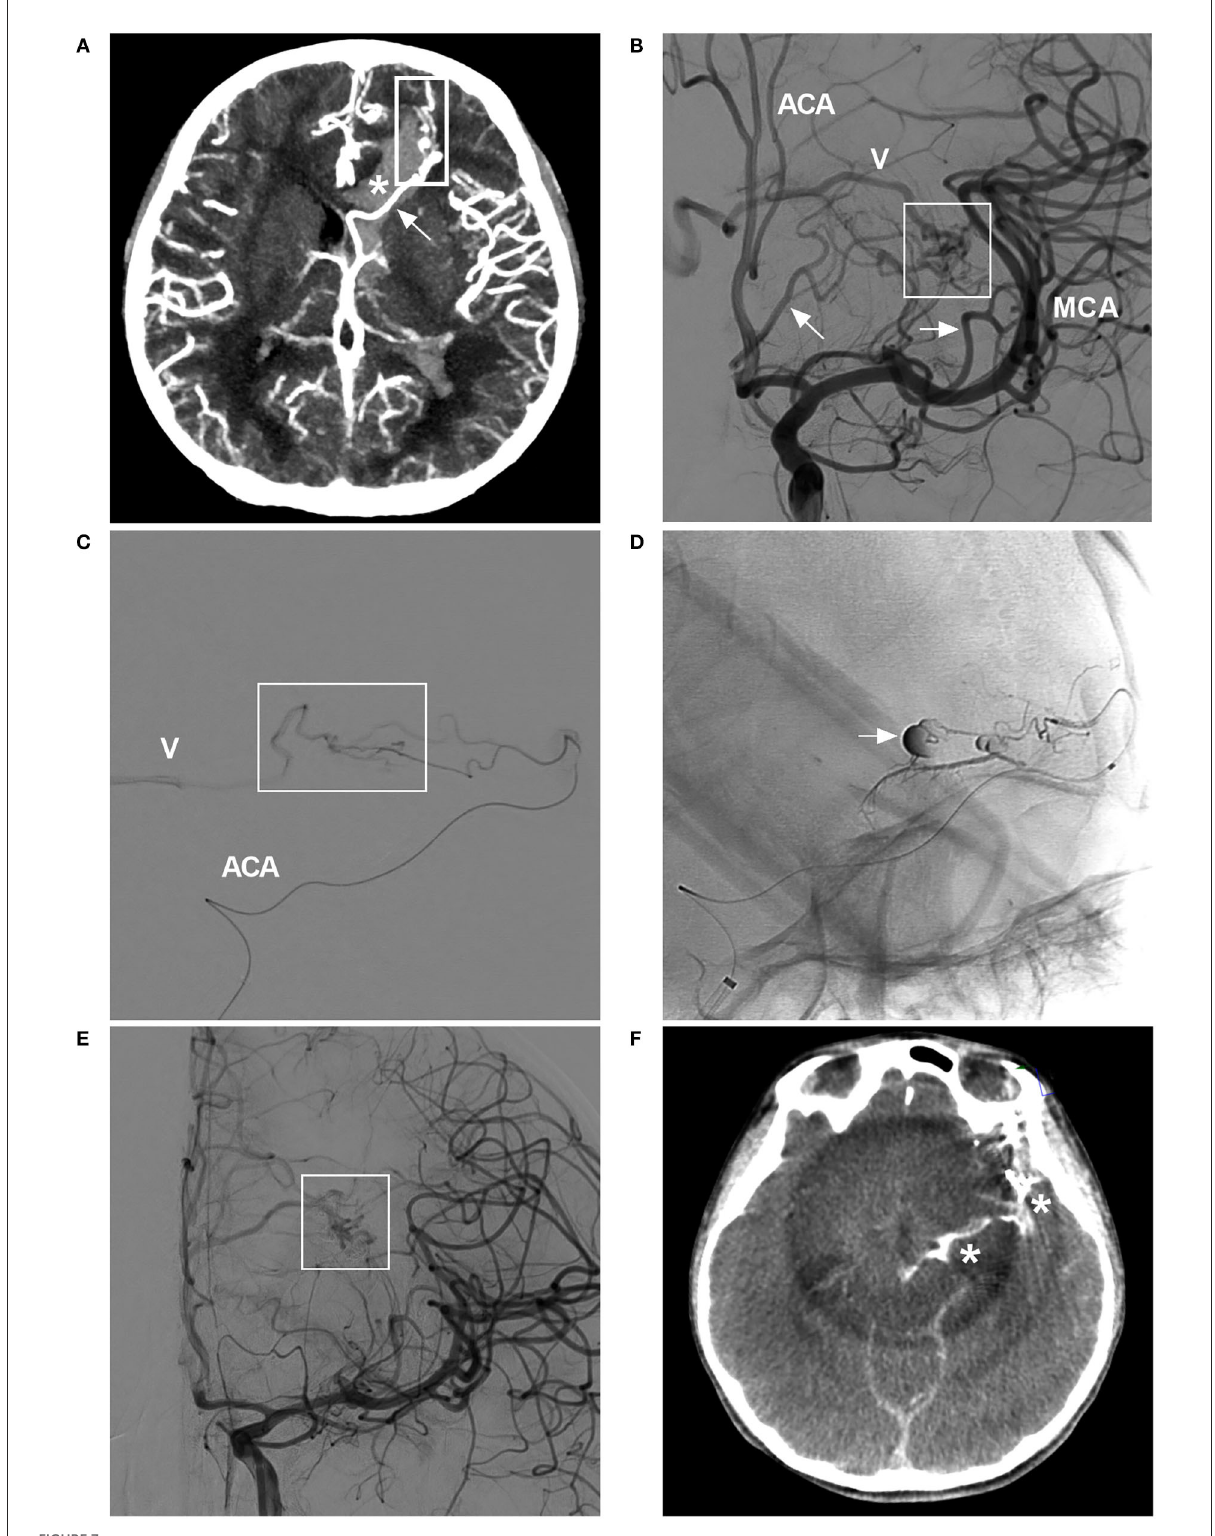
FIGURE7 BAVM with intraoperative rupture from Onyx casting (case 25). (A) CT angiogram showing BAVM (frame) draining into the deep vein system (arrow), with a rupture into the ventricle (asterisk). (B) Angiogram of the ICA showing the BAVM (frame) supplied by the ACA and MCA